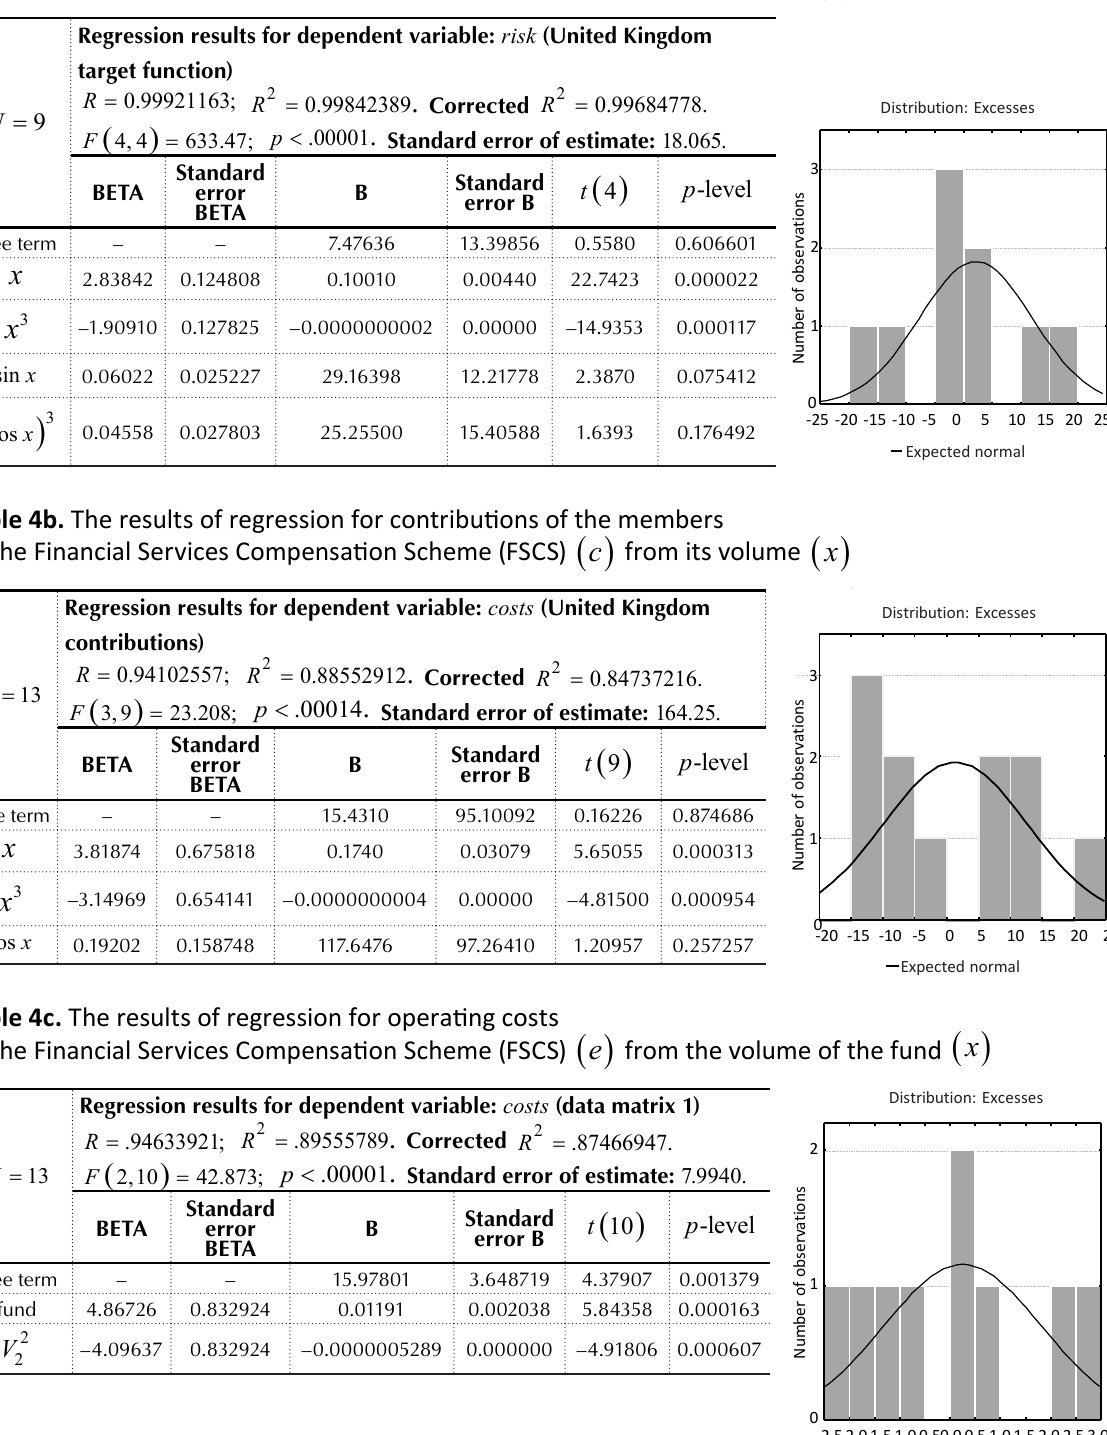
Table 4a. The results of regression for standard deviation of the size of the Financial Services Compensation Scheme (FSCS)